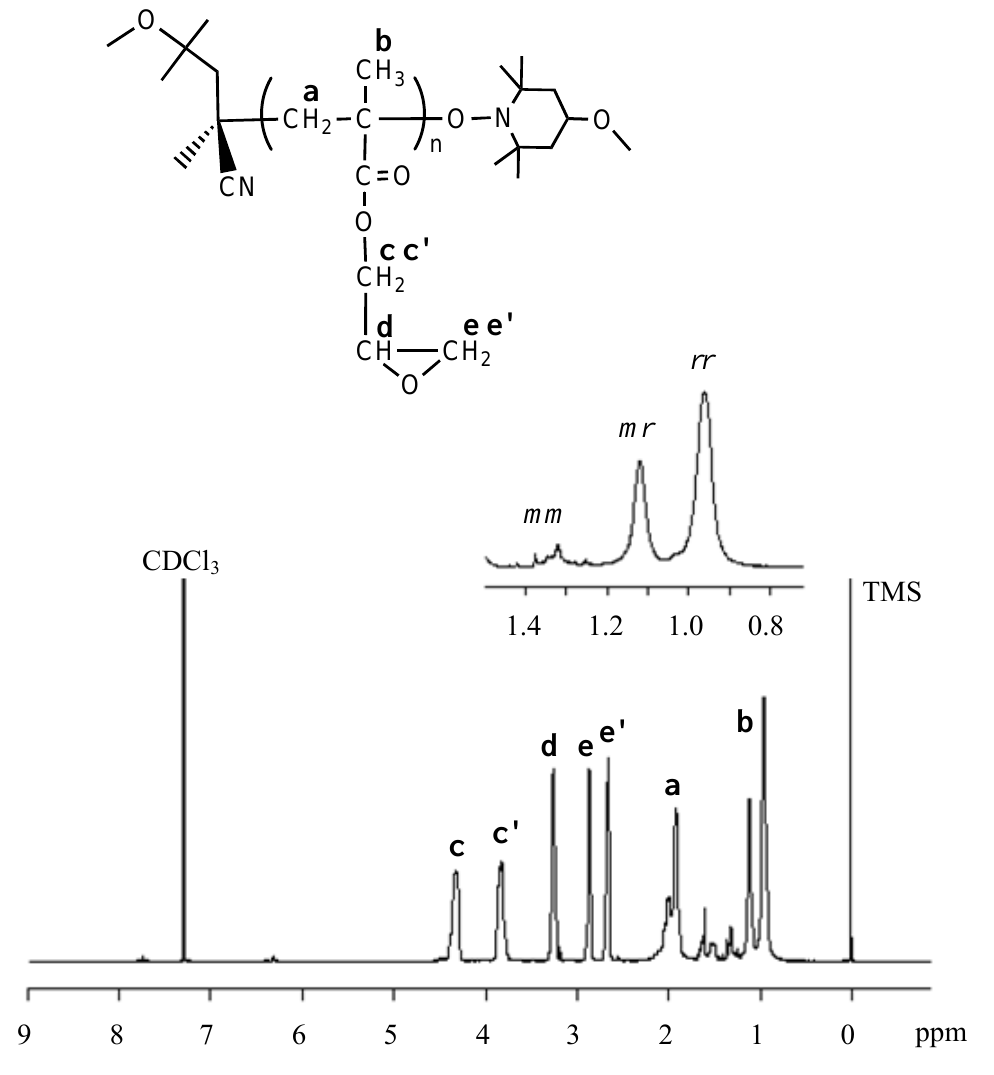
Figure 2. The 1 H NMR spectrum of the poly(glycidyl methacrylate) (PGMA) obtained by the MTEMPO-mediated photopolymerization. Conversion = 58%, M / M = 1.48. Solvent: CDCl M w n